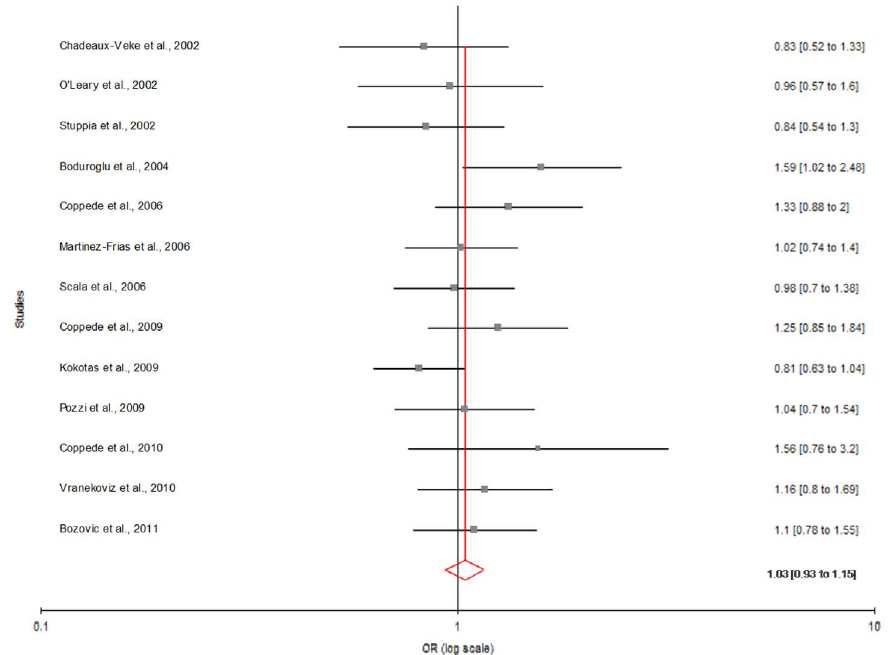
Figure 7. Forest plots (Fixed effect) showed no association between MTHFR C677T polymorphism and risk of Down syndrome in European studies using allele contrast model (T versus C). Results of individual and summary OR estimates and 95% CI of each study were shown. Horizontal lines represented 95% CI, and dotted vertical lines represent the value of the summary OR.